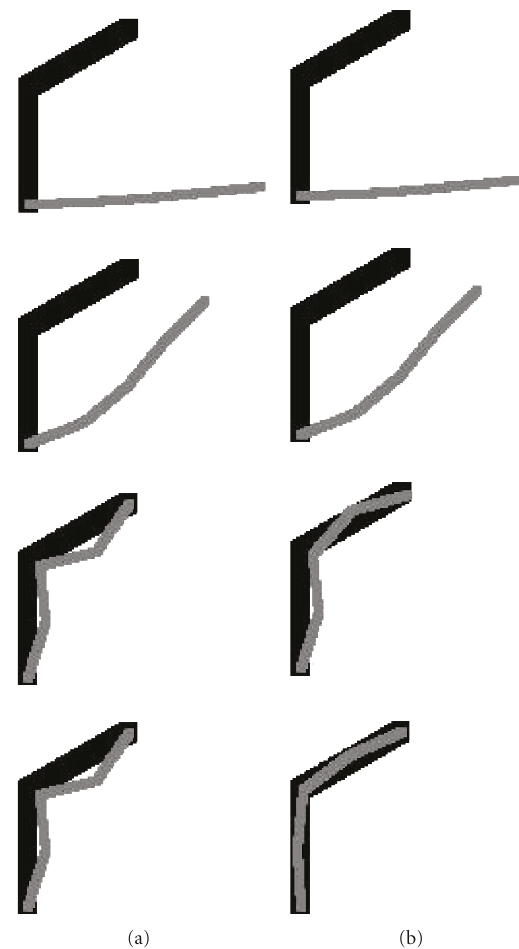
Figure 6: Experiment 1. From the initial configuration of the articulated chain (gray), both approaches try to reach the objective configuration (black). Left column, sequence applying inverse kinematics without image constraint. Right column, sequence applying inverse kinematics with image